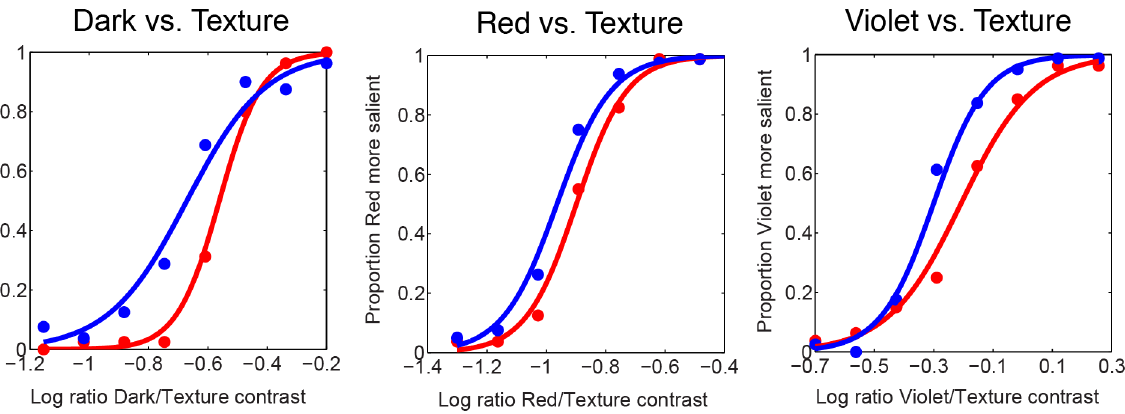
Fig. 2. Example psychometric functions. Psychometric functions from observer P2, for all three cue combinations and the two presentation conditions: left: dark vs. texture, middle: red vs. texture, and right: violet vs. texture. Graphs show the proportion of trials on which the non-texture cue was judged to produce the stronger orientation structure as a function of the logarithm of the ratio of non-texture cue contrast to texture contrast. Blue symbols show data from the Separate condition; red Combined. Lines show best fit logistic functions – see main